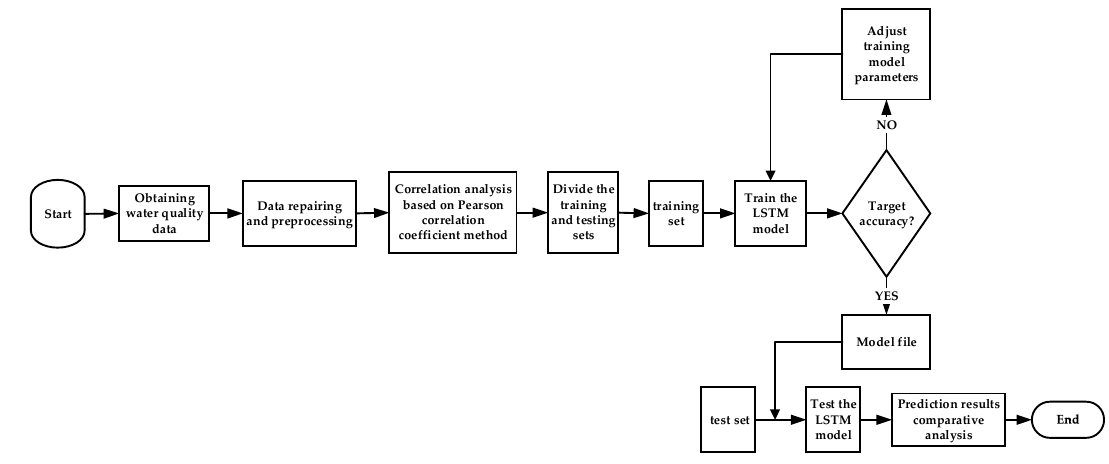
Figure 6. The complete flowchart of the water quality prediction model.